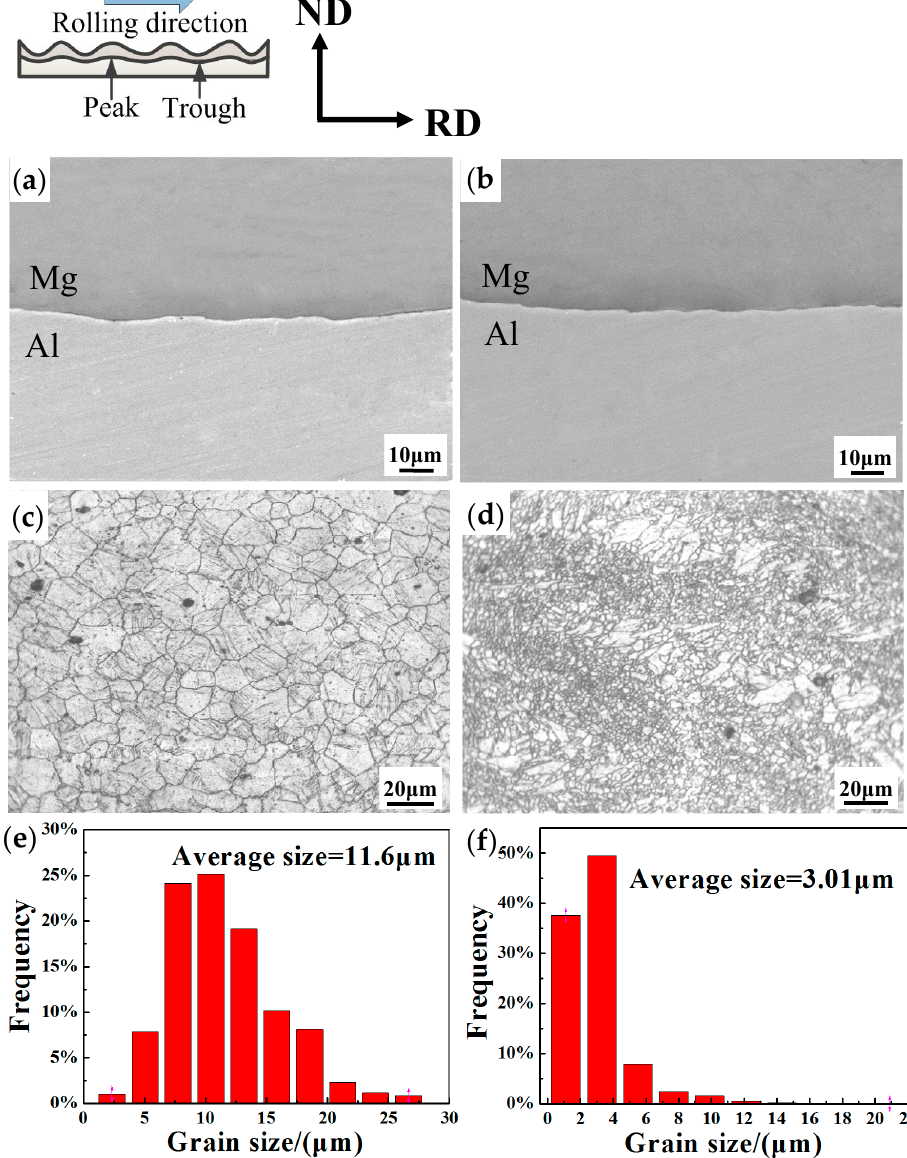
Figure 4. SEM images of the bonding interface and OM images of the AZ31B near the corrugated roll for the corrugated composite: ( a , c , e ) peak position; and ( b , d , f ) trough position.